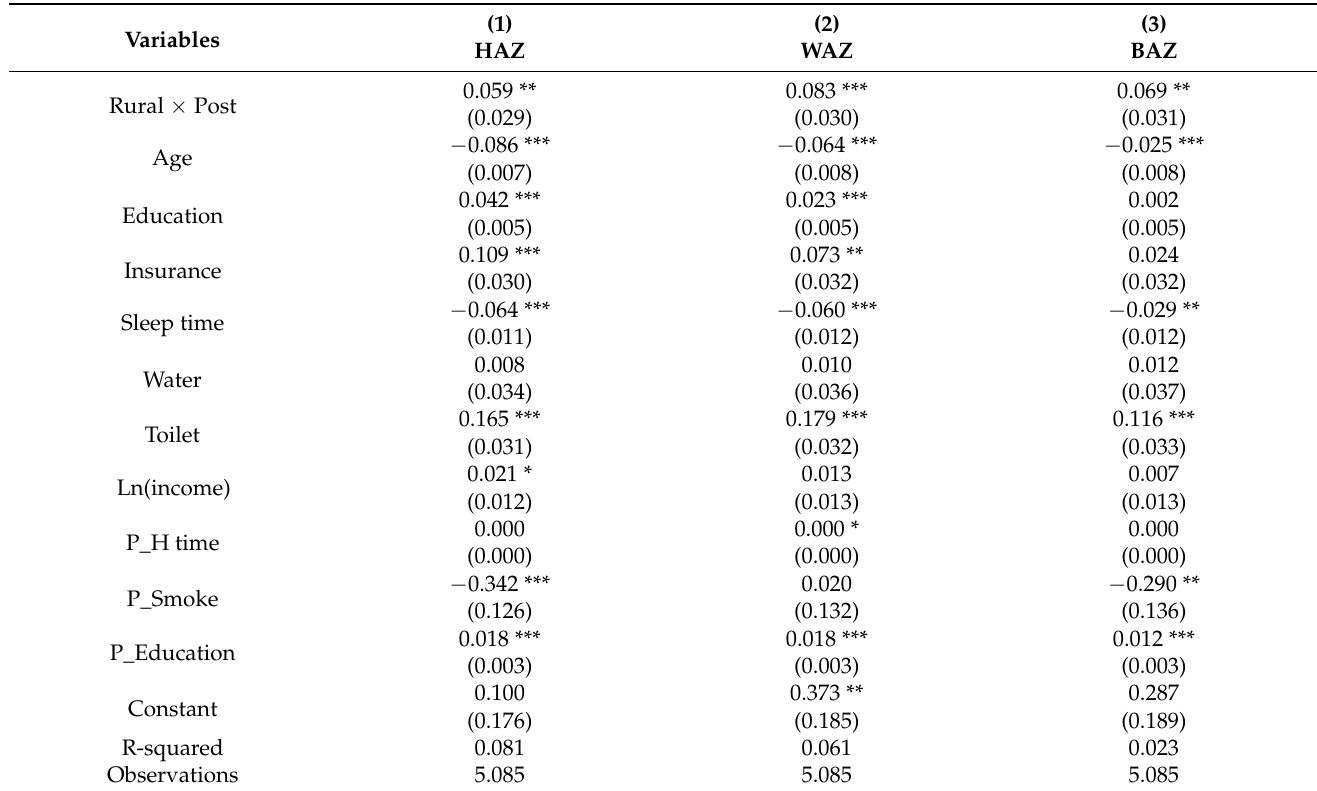
Table 3. Benchmark regression estimation results for the effect of household technology on child